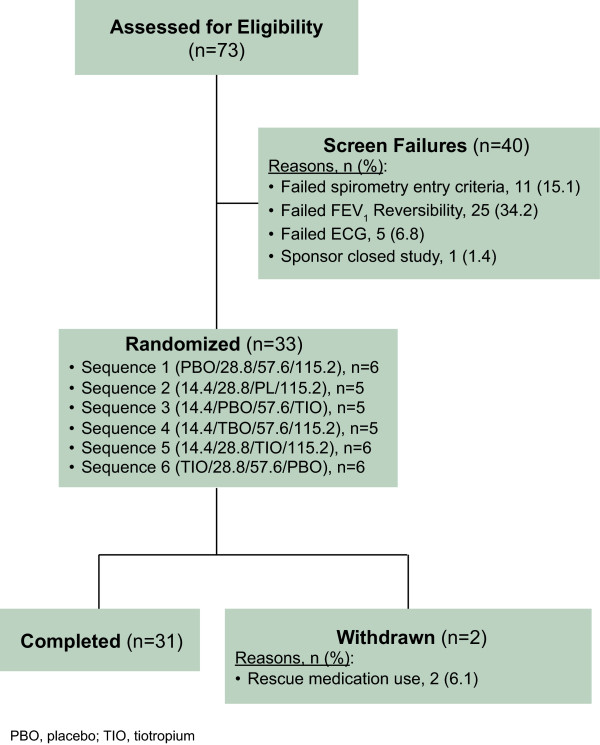
Study patient disposition; reports the overall enrollment, allocation, and follow-up for study patients. Two patients were excluded for both failed FEV1 reversibility and a failed ECG, making the total number of patients who failed screening 40.